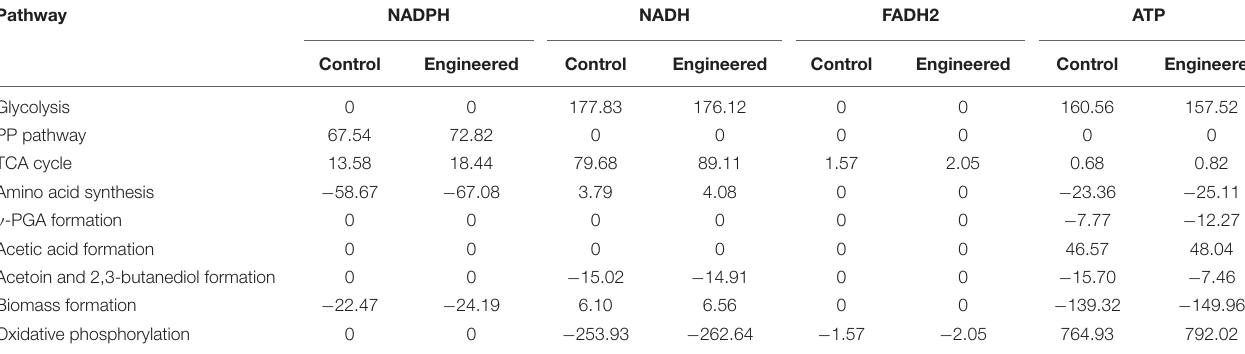
TABLE 3 | The synthesis and consumption contents of NADPH, NADH, ATP, and FADH2 of WX-02/pHY300 and WX-02/pHY- dltB (mmol/g CDW/h). Pathway NADPH NADH